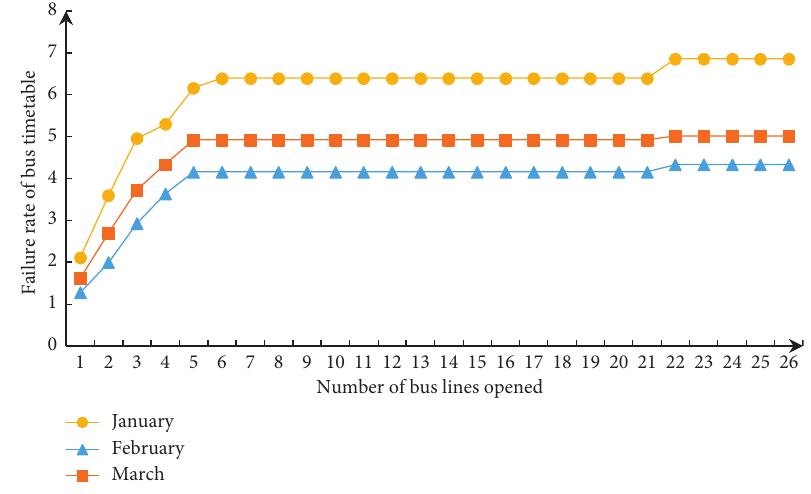
Figure 7: Timetable failure rate for each bus line during the